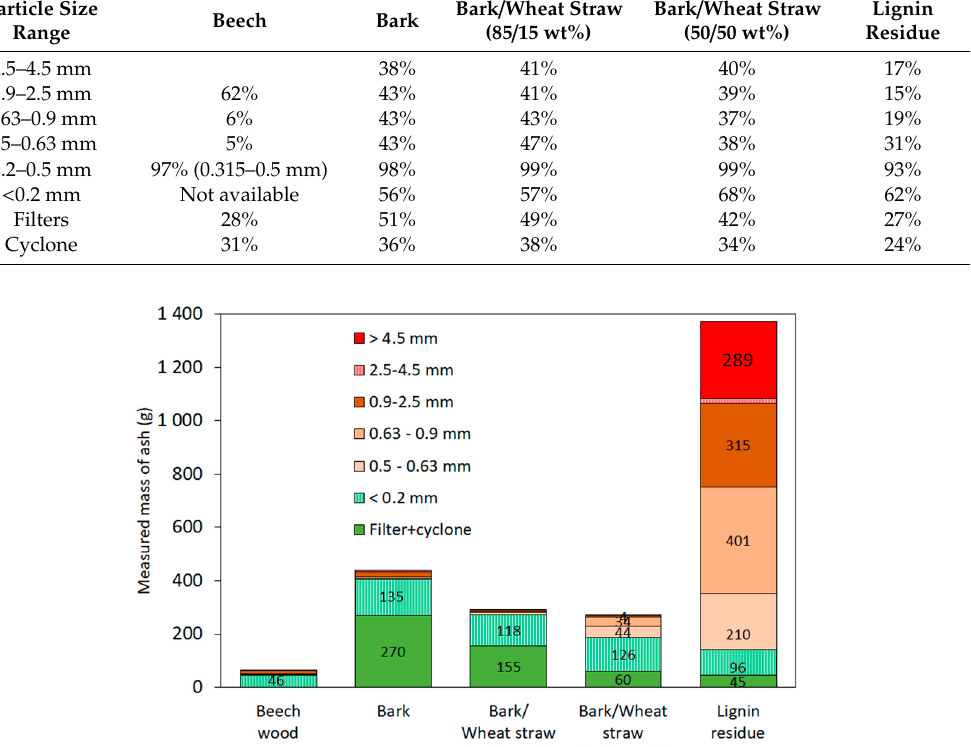
Figure 8. Mass of ash as a function of residue particle class for each feedstock after combustion tests in fluidised bed.